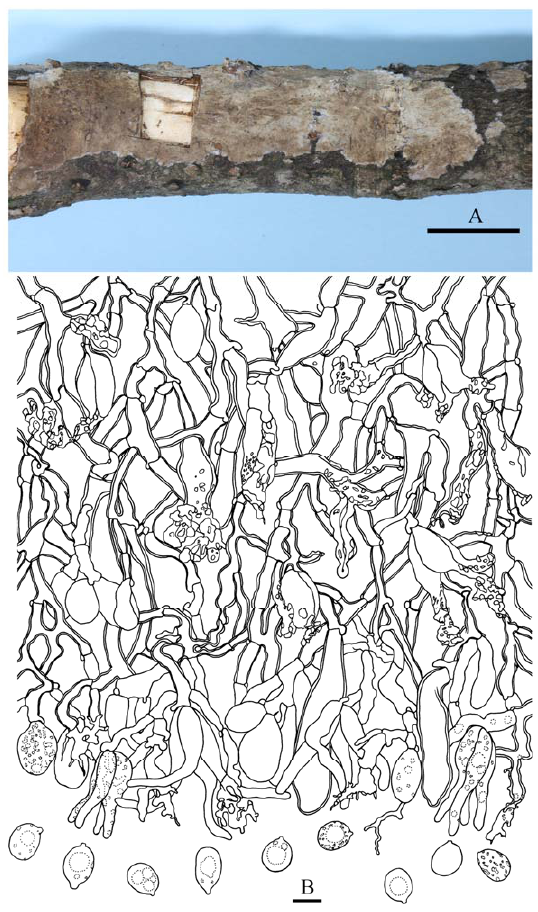
Figure 8. Heterocorticium latisporum (from the holotype, He 20120923 ‐ 20, BJFC 014667). Scale bars: ( A ) = 1 cm; ( B ) = 10 μ m. ( A ). Basidiomes; ( B ). A cross section of the